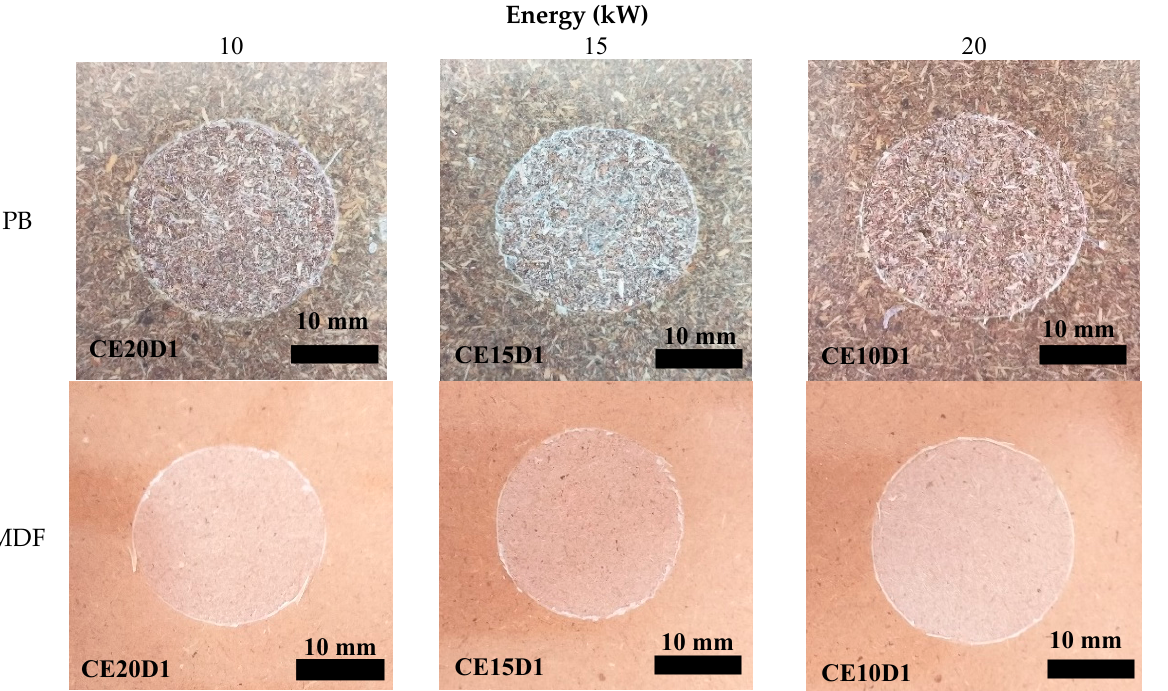
Figure 7. The adhesion strength of PB and MDF samples after adhesion strength tests. Table 4. Cross-cutting rating of coated